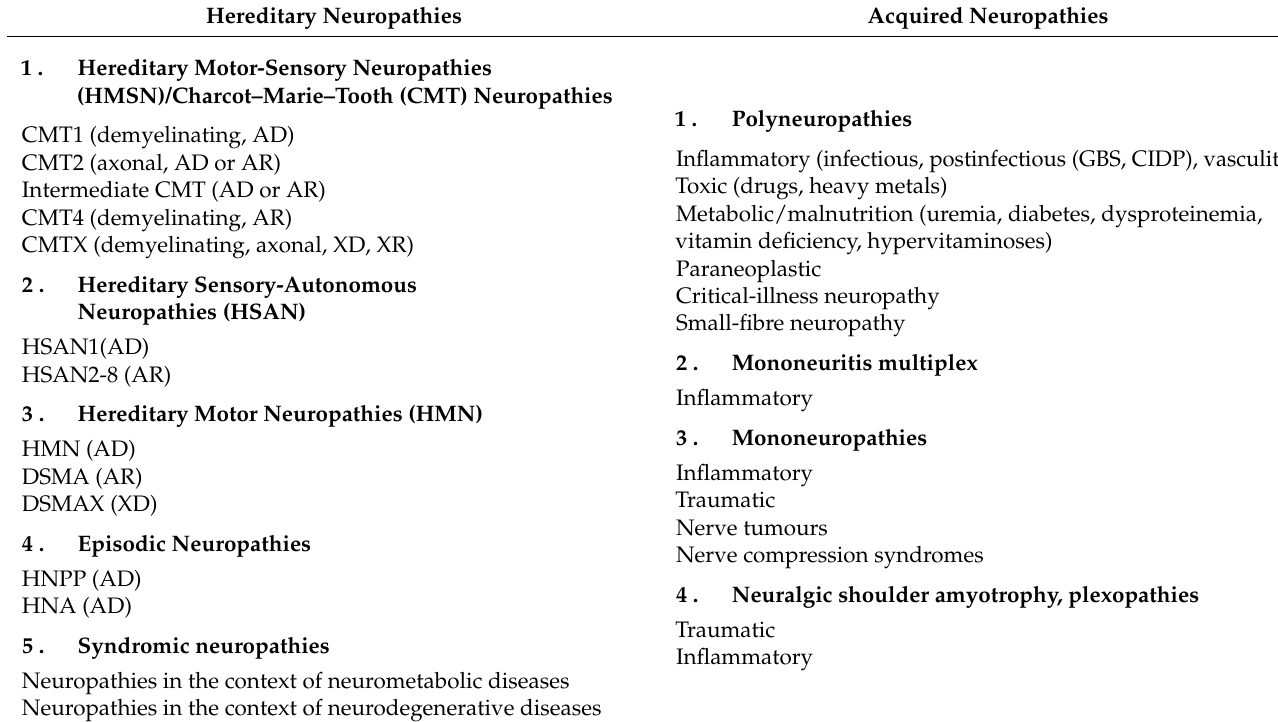
Table 1. Survey of neuropathies in children and